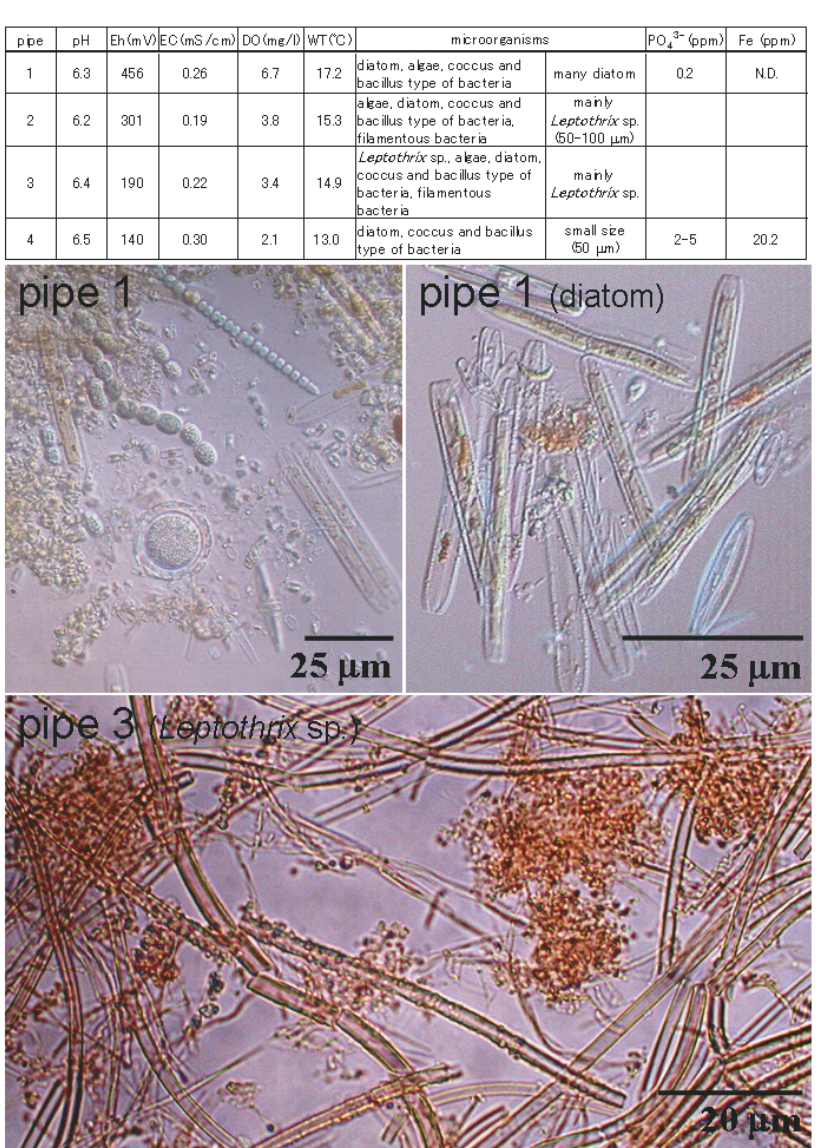
Fig. 8 – Characteristic ground water at landslide areas in Takayanagi in Niigata (upper left) and microorganisms inhabited in the drainage pipes (upper right). Optical micrographs of microor- ganisms in the microbial mats collected from pipes 1 and 3